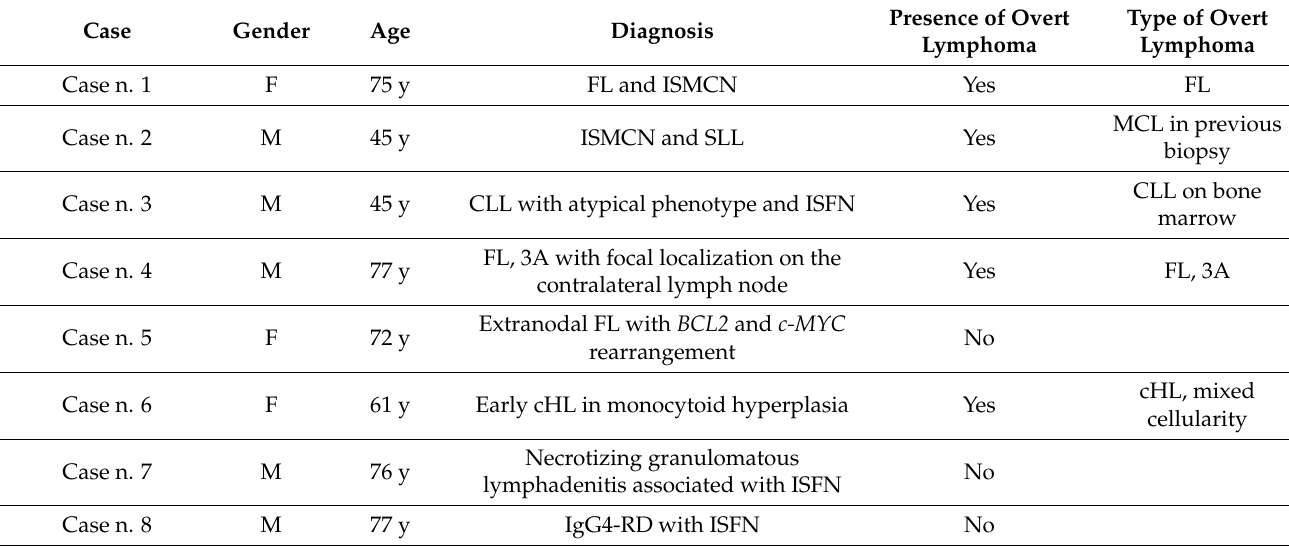
Table 2. Clinical cases presented during the